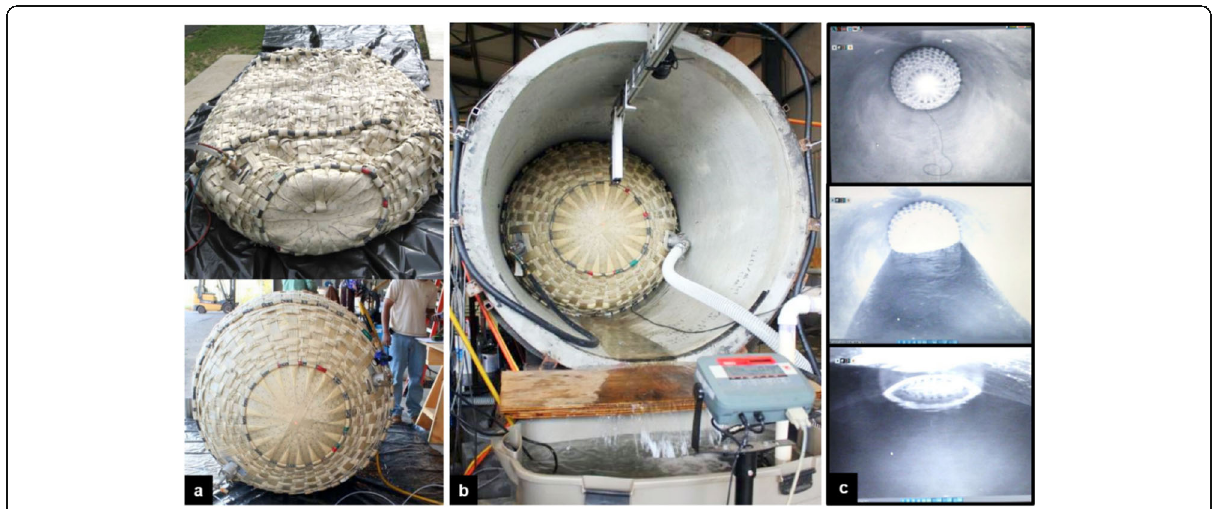
Fig. 7 Phase 2b, reduced-scale testing: a Unconfined inflation of quarter-scale plug; b Front view of confined inflation and flooding simulation; c Back view quarter-scale tunnel during flooding testing